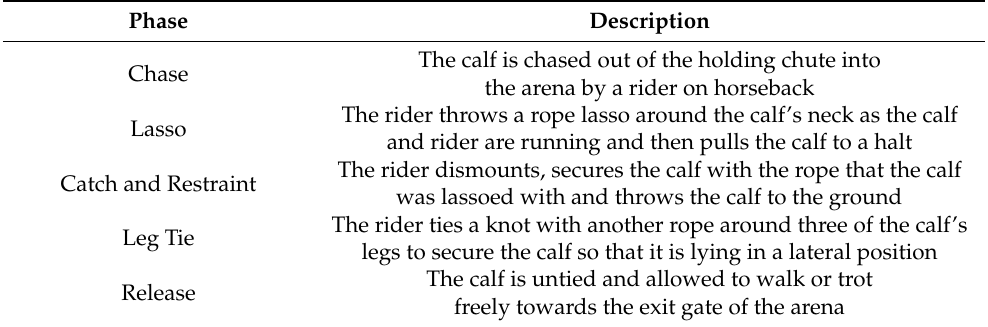
Table 1. Descriptions of the five phases of calf roping used for this study, including definitions developed by the authors. Phase Description The calf is chased out of the holding chute into Chase the arena by a rider on horseback The rider throws a rope lasso around the calf’s neck as the calf Lasso and rider are running and then pulls the calf to a halt The rider dismounts, secures the calf with the rope that the calf Catch and Restraint was lassoed with and throws the calf to the ground The rider ties a knot with another rope around three of the calf’s Leg Tie legs to secure the calf so that it is lying in a lateral position The calf is untied and allowed to walk or trot Release freely towards the exit gate of the arena Adapted from Rizzuto et al. (2020).